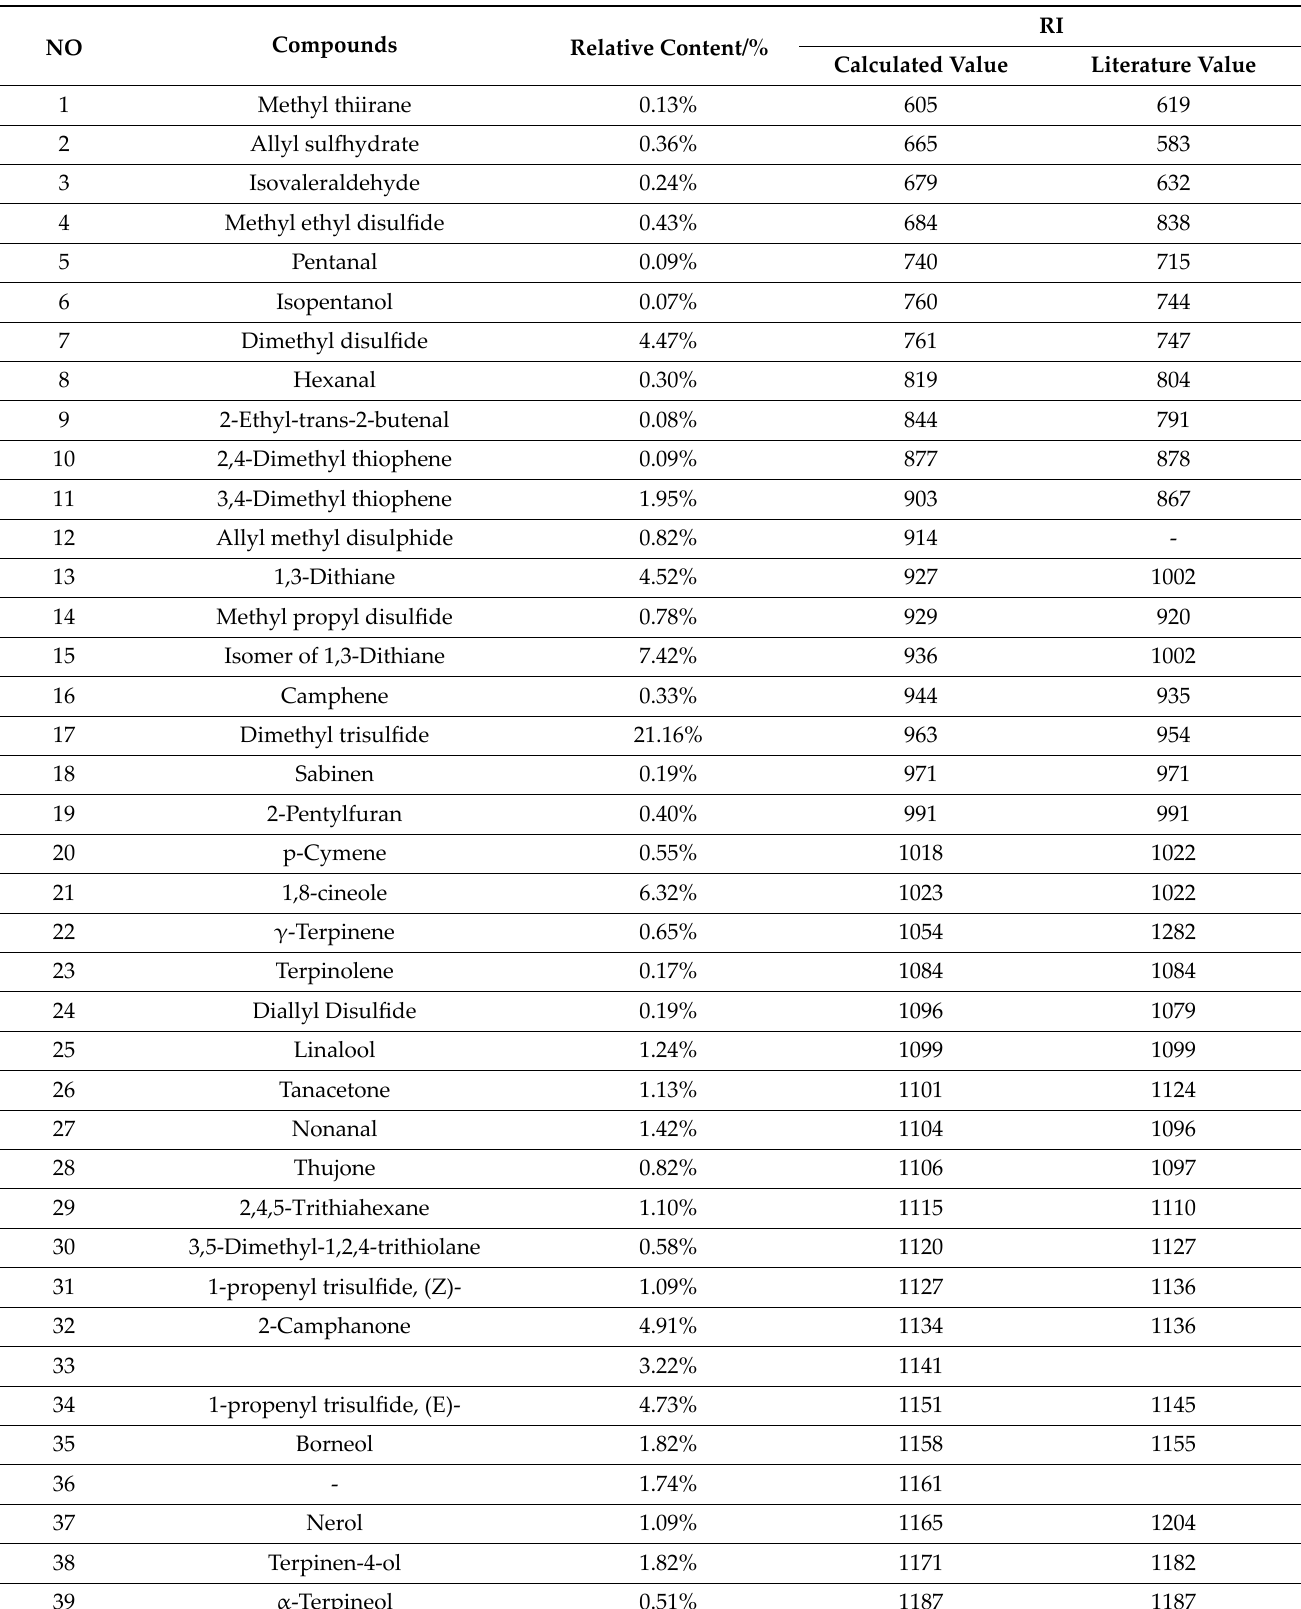
Table 1. GC‑MS analytical results of composition for the Allium tenuissimum L. flowers essential